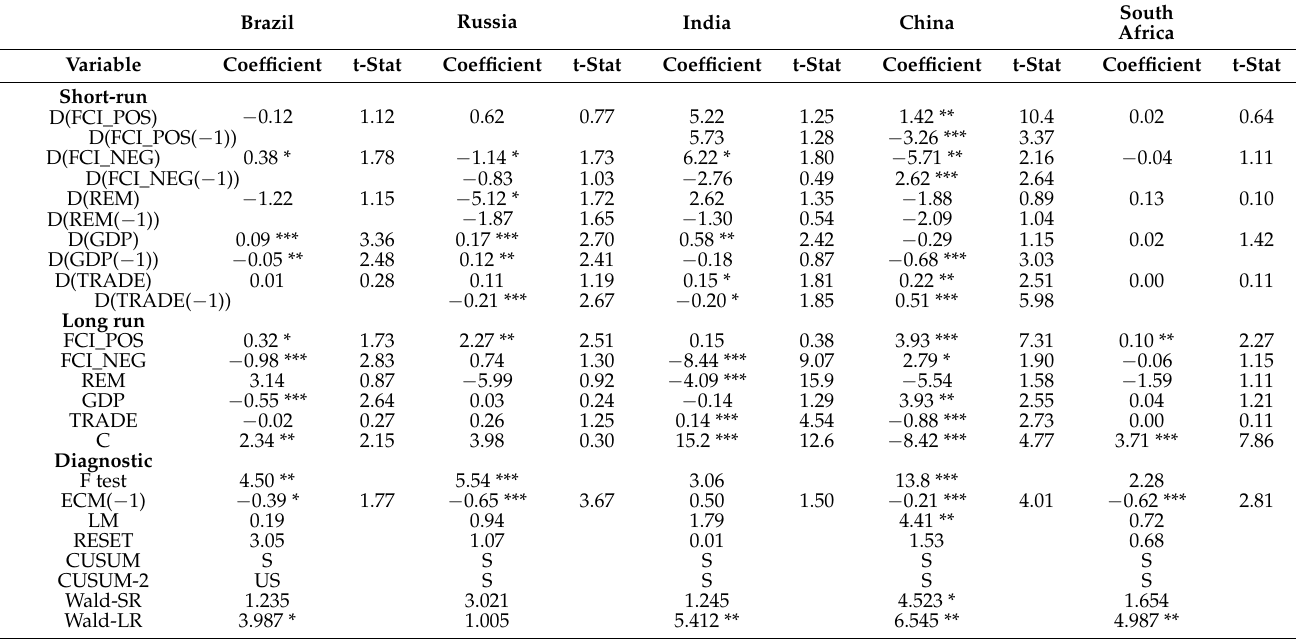
Table 4. Short and long-run NARDL estimates of non-renewable energy